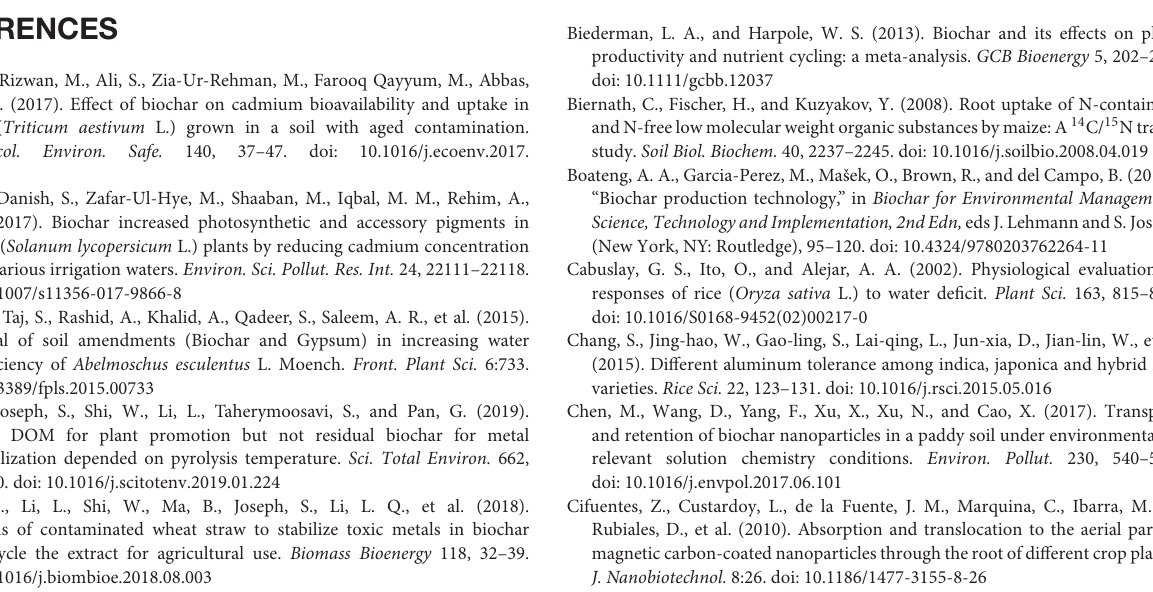
Supplementary Figure 1 | Schematic diagram of the hydroponic Experiment 1 and Experiment 2. Supplementary Figure 2 | Morphological phenotype of Wuyunjing 7 in Experiment 1. Supplementary Figure 3 | Morphological phenotype of Nipponbare in Experiment 1. Supplementary Figure 4 | Morphological phenotype of Wuyunjing 7 in Experiment 2a. Supplementary Figure 5 | Morphological phenotype of Wuyunjing 7 in Experiment 2b. Supplementary Table 1 | Composition of adjusted IRRI nutrient solution. Supplementary Table 2 | Fresh shoot and root biomass of Wuyunjing 7 in Experiment 1. Supplementary Table 3 | Rice root morphology of Wuyunjing 7 in Experiment 1. Supplementary Table 4 | Rice root distribution parameters of Wuyunjing 7 in Experiment 1. Supplementary Table 5 | Dry shoot and root biomass of Wuyunjing 7 in Experiment 2a. Supplementary Table 6 | Rice nutrients content and transfer coefficient of Wuyunjing 7 in Experiment 2a. Supplementary Table 7 | Rice leaf photosynthetic traits of Wuyunjing 7 in Experiment 2b. Supplementary Table 8 | Rice root morphology of Wuyunjing 7 in Experiment 2a. Supplementary Table 9 | Rice root distribution of Wuyunjing 7 in Experiment 2a. Supplementary Table 10 | Shoot and root water content of Wuyunjing 7 in Experiment 2. Supplementary Table 11 | Putative identifications with gas chromatograph-mass spectrometer (GC-MS) of compounds in hot water extract from maize residue